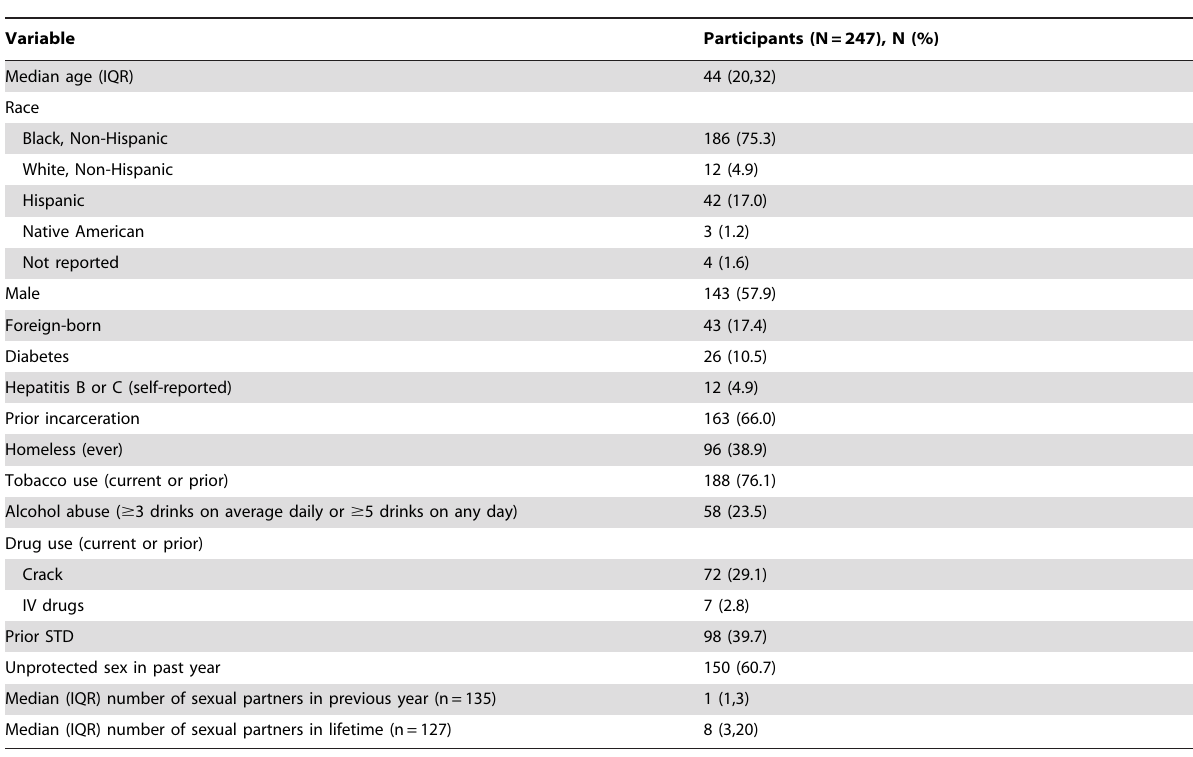
Table 1. Demographics and Behaviors of Study